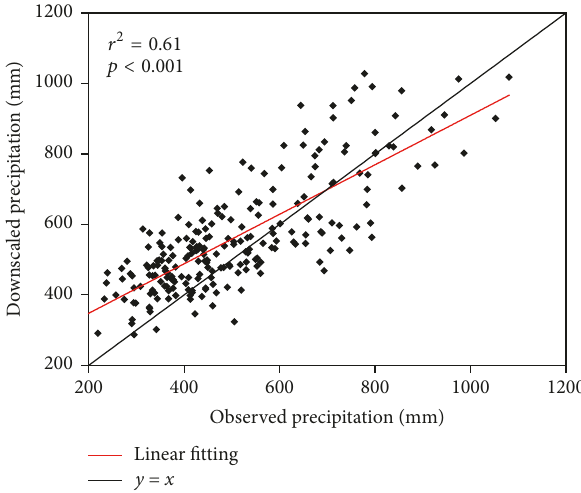
Figure6:Scatterdiagramoftheprecipitationobservedatraingauge stations and the downscaled precipitation.